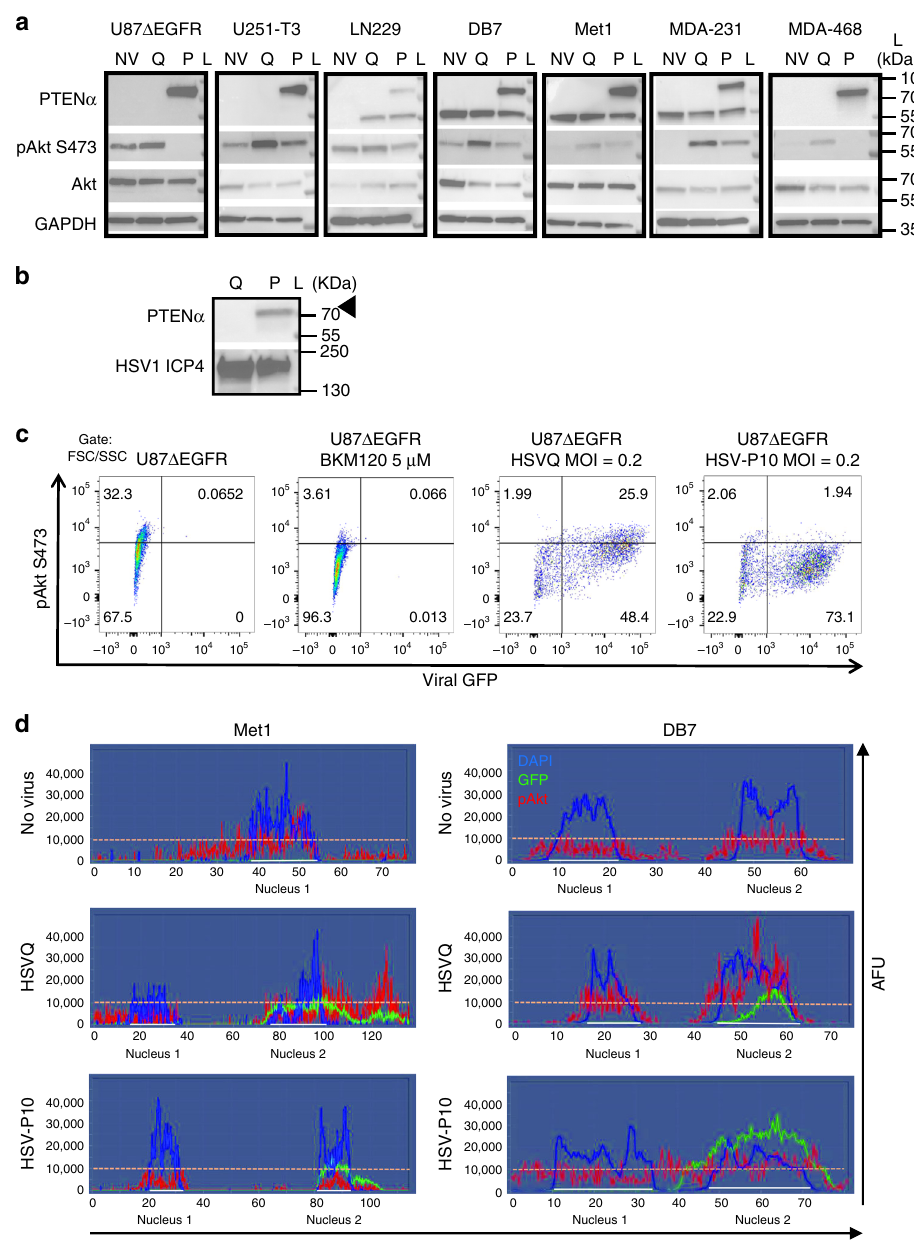
Fig. 2 HSV-P10 AKT inhibition. a Western blots of lysates from the indicated cells infected with HSVQ (Q) or HSV-P10 (P) or left untreated (NV). Infected cells (MOI = 1) were lysed 24 hpi and probed for expression of PTEN α , pAKT (S473), Akt, and GAPDH. L indicates the moleculcar weight ladder. b Western blot for secreted PTEN expression in conditioned medium. Culture media was concentrated 20X from U87 Δ EGFR cells infected 24 h with either HSVQ (Q) or HSV-P10 (P10) and probed for secreted PTEN α . L indicates the molecular weight ladder. c Flow cytometric analysis of pAkt-S473 and virus encoded GFP in infected U87 Δ EGFR cells 15 hpi. d Spectral analysis of fl uorescent intensity along a random line drawn across the view fi eld of one or two cells visualizing pAKT (red), DAPI (blue) and GFP (green) of the indicated cells. y -axis represents arbitrary fl uorescence units (AFU). Note the higher intensity of pAKT in HSVQ-infected (GFP positive) cells relative to adjacent uninfected (GFP negative) cell (middle panel). Note the lack of increased pAKT intensity in HSV-P10 infected (GFP positive) cells relative to adjacent uninfected (GFP negative) cells (bottom panel) The differentiated neurons and MDA-468 cells were infected with (Gating on MAP2 + HSV-GFP + cells, Supplementary Figure 2). HSVQ or HSV-P10 with MOI 0.1 or MOI 0.5 for 72 h. As Consistent with the known clinical safety of HSV viruses deleted expected both HSVQ and HSVP-10 could infect primary human for viral neurovirullence genes ICP34.5, we observed no evidence neurons, and consistent with increased HSV-P10 spread in cancer of increased apoptosis towards these cells in vitro (Fig. 5e). This cell cultures, a greater number of MDA-MB-468 cells were suggests that PTEN expression by the virus did not alter the safety positive for GFP at either MOI, with HSV-P10 relative to HSVQ pro fi le of the virus in normal cells (Fig. 5d, e). MDA-MB-468 (Fig. 5d). The apoptosis of infected neurons and MDA-468 cells tumor cells were used as controls for the toxicity assay and was analyzed by Annexin-V/PI staining of HSV-infected neurons showed increased sensitivity to HSV-P10 relative to HSVQ. NATURE COMMUNICATIONS| (2018) 9:5006 |DOI: